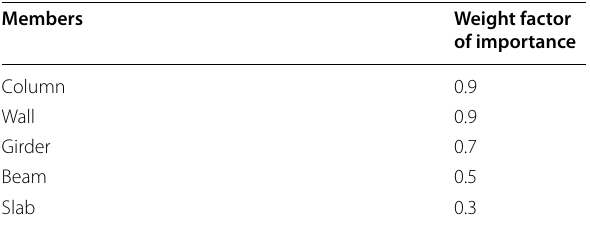
Table 3 Weight factor of importance for RC frame